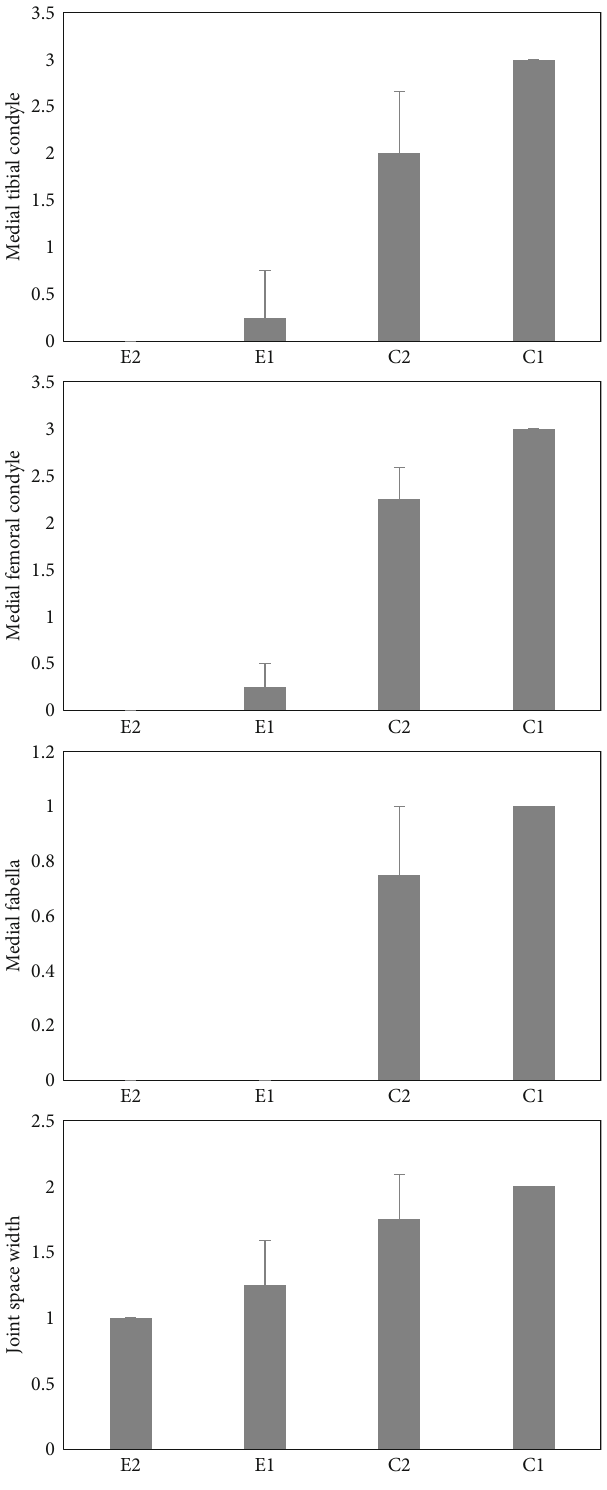
Figure 3: Radiological scores regarding OA in rat models including E2 group: synovial membrane-based stem cells, E1 group: adipose tissue-derived stem cells, C2 group: treated with Hyalgan, and C1 group: nontreated, based on International Cartilage Repair Society (ICRS). Values are shown as the median and interquartile range. ∗ p value < 0.05 vs.